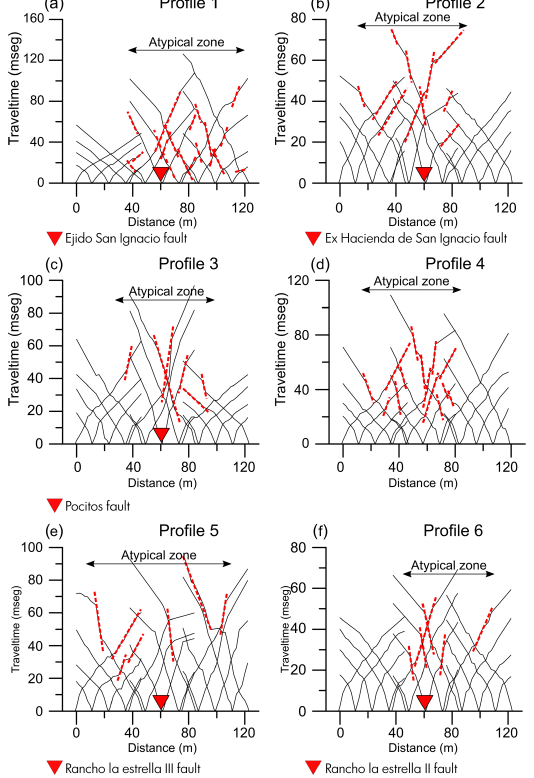
Figure 4. Domocrones of the six studied sites. Red dotted lines indicate the anomalous low-velocity of seismic waves propagation.